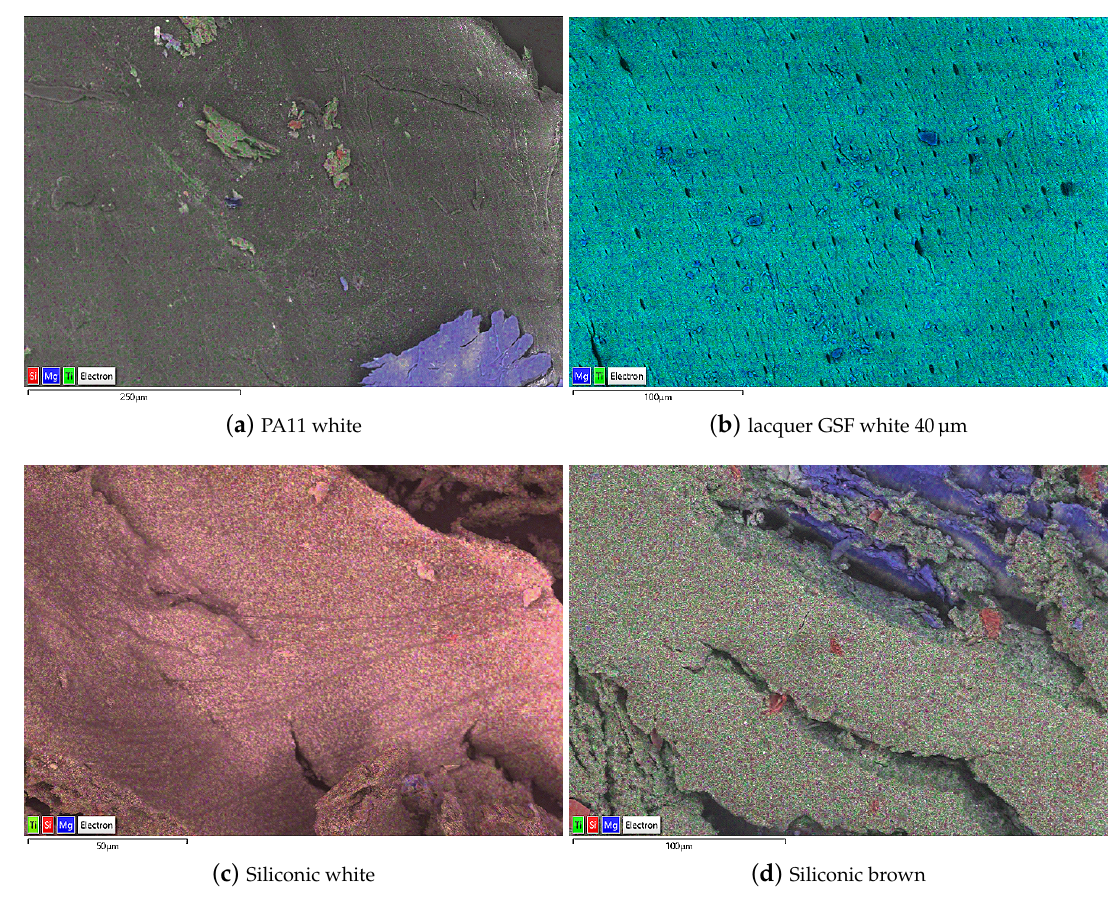
Figure 8. EDS maps of the four samples of the third step of